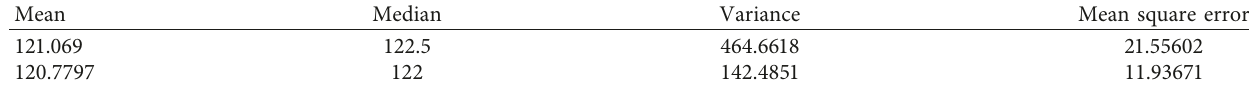
Table 3: The analysis of bus travel time in Group A and Group